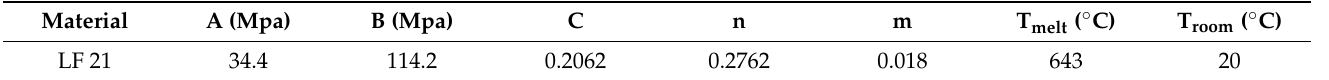
Table 4. Parameters of Johnson–Cook constitutive model of aluminum alloy LF 21.